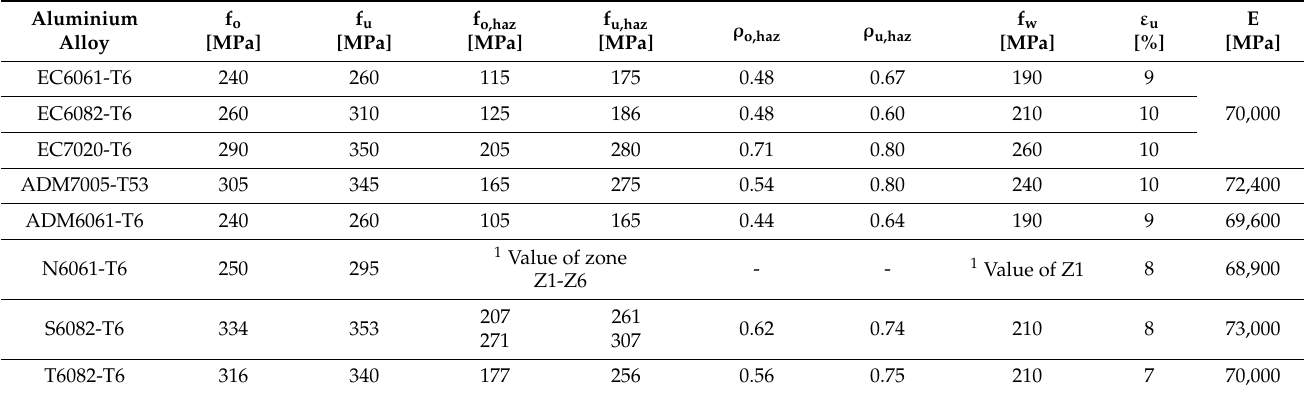
Table 3. Mechanical properties of aluminium alloys.